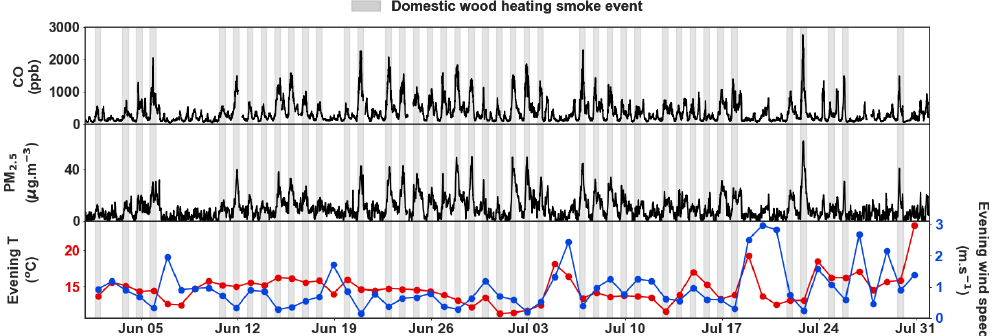
Figure 6. Time series of CO, PM 2.5 , evening temperature and wind speed (averaged between 16:00 and 22:00) during June and July 2017. Shading highlights domestic wood heating smoke